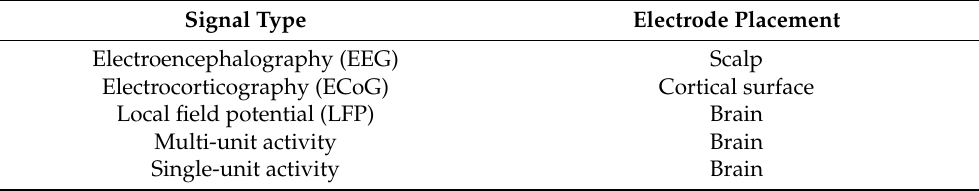
Table 4. Different types of extracellular electrical signals in the brain